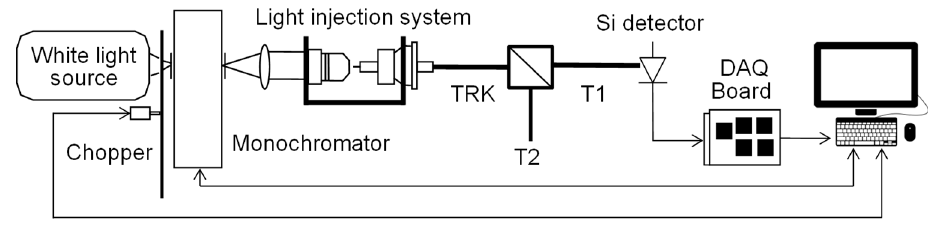
Figure 2. Experimental set-up to measure spectral attenuation. 68